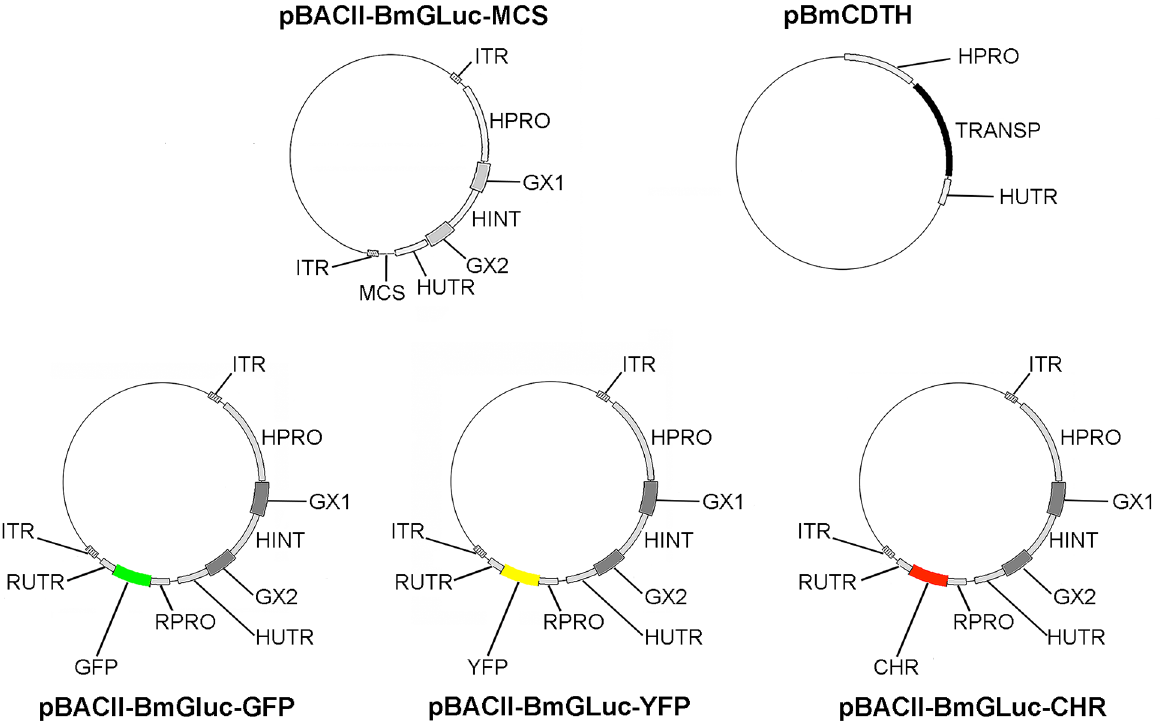
Fig 1. Maps of plasmid constructs used in this study. ITR = inverted terminal repeat; HPRO = BmHSP70 promoter; GX1 = Gaussia luciferase ORF exon 1; HINT = BmHSP70 intron 1; GX2 = Gaussia luciferase ORF exon 2; HUTR = BmHSP703' UTR; MCS = multiple cloning site ( Bcl